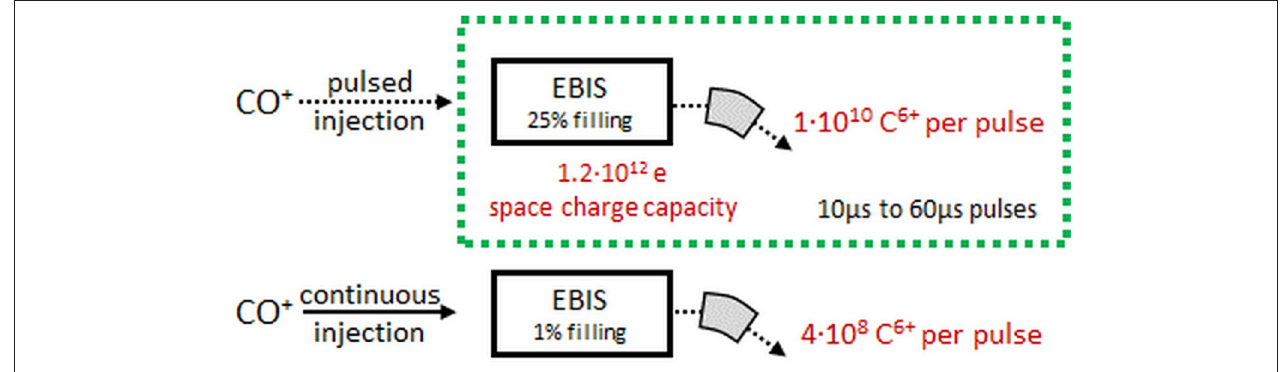
FIGURE 11 | Extracted C 6 + intensity for pulsed and continuous injection into an EBIS, assuming a space charge capacity of 1.2x10 12 charges [adapted from (95)].